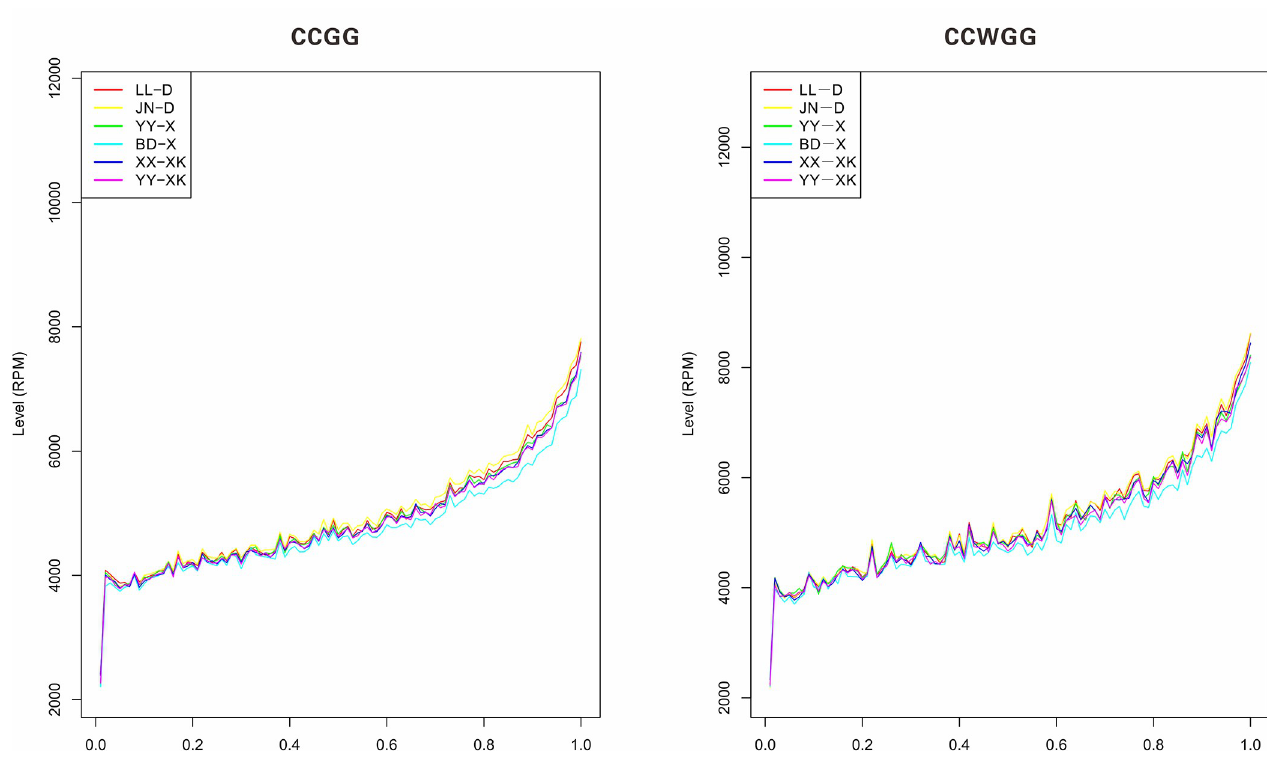
Fig 2. Methylation level of gene